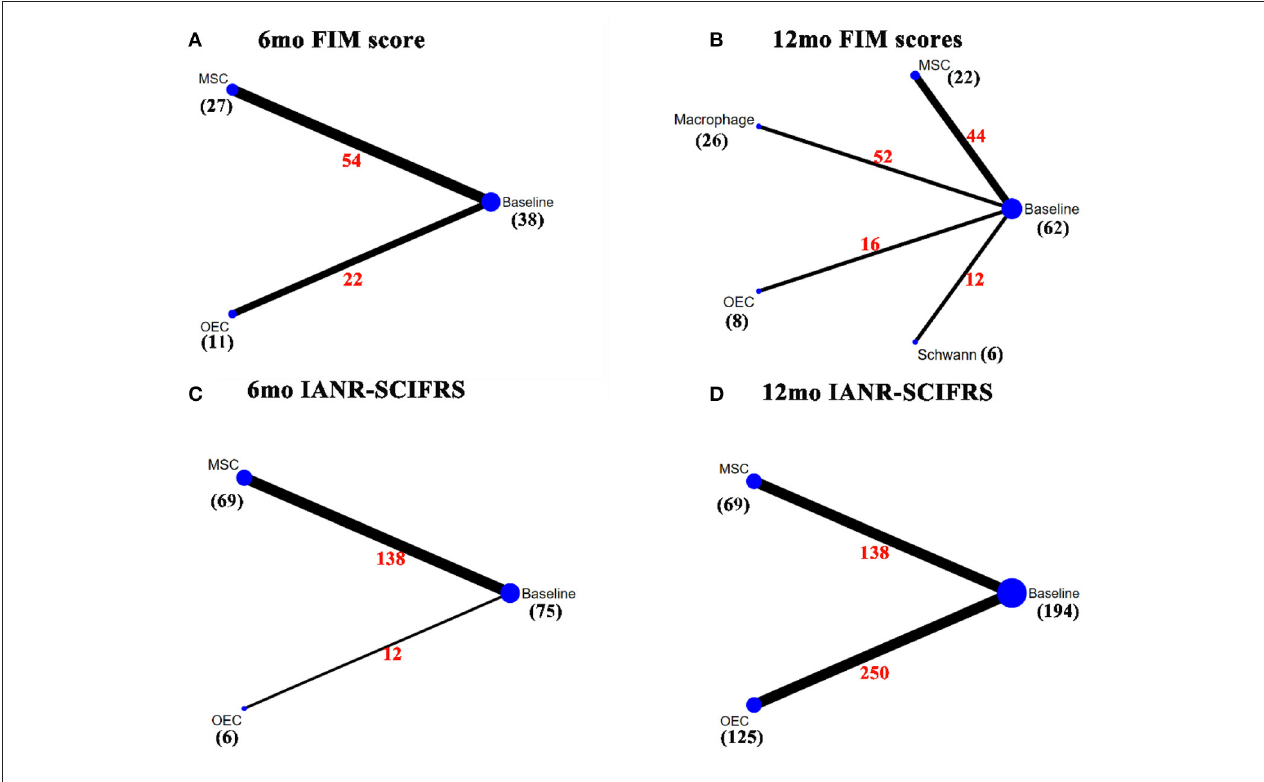
FIGURE 4 | Network plot for FIM score and IANR-SCIFRS. (A) A network plot for 6mo FIM score; (B) A network plot for 12mo FIM score; (C) A network plot for 6mo IANR-SCIFRS; (D) A network plot for 12mo IANAR-SCIFRS. The nodes represent different interventions, the size of the nodes represents the sample size of that intervention, and the thickness of the lines connecting the nodes represents the sample size involving both interventions. The black number represents the sample size of the intervention, and the red number represents the total sample size of the two connected interventions. FIM, Functional independence measure; IANR-SCIFRS, International Association of Neurorestoratology Spinal Cord Injury Functional Rating Scale; mo, month; MSC, mesenchymal stem cell; NSC, neural stem cell/neural progenitor cell; OEC, olfactory ensheathing cell.